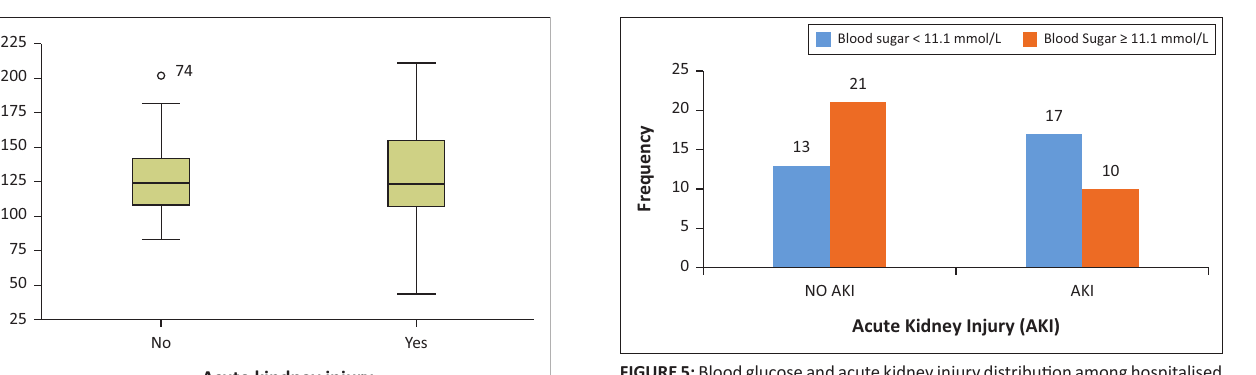
FIGURE 5: Blood glucose and acute kidney injury distribution among hospitalised patients who died due to